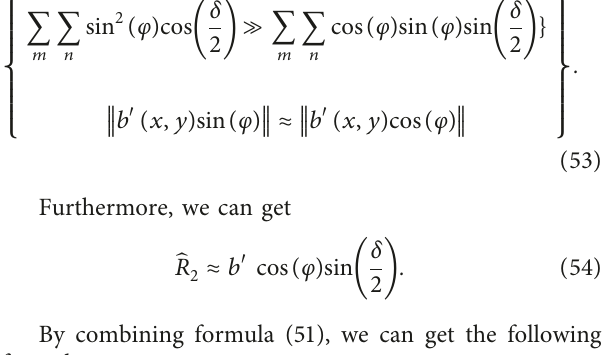
Finally, the measured height of the three-dimensional object is obtained as